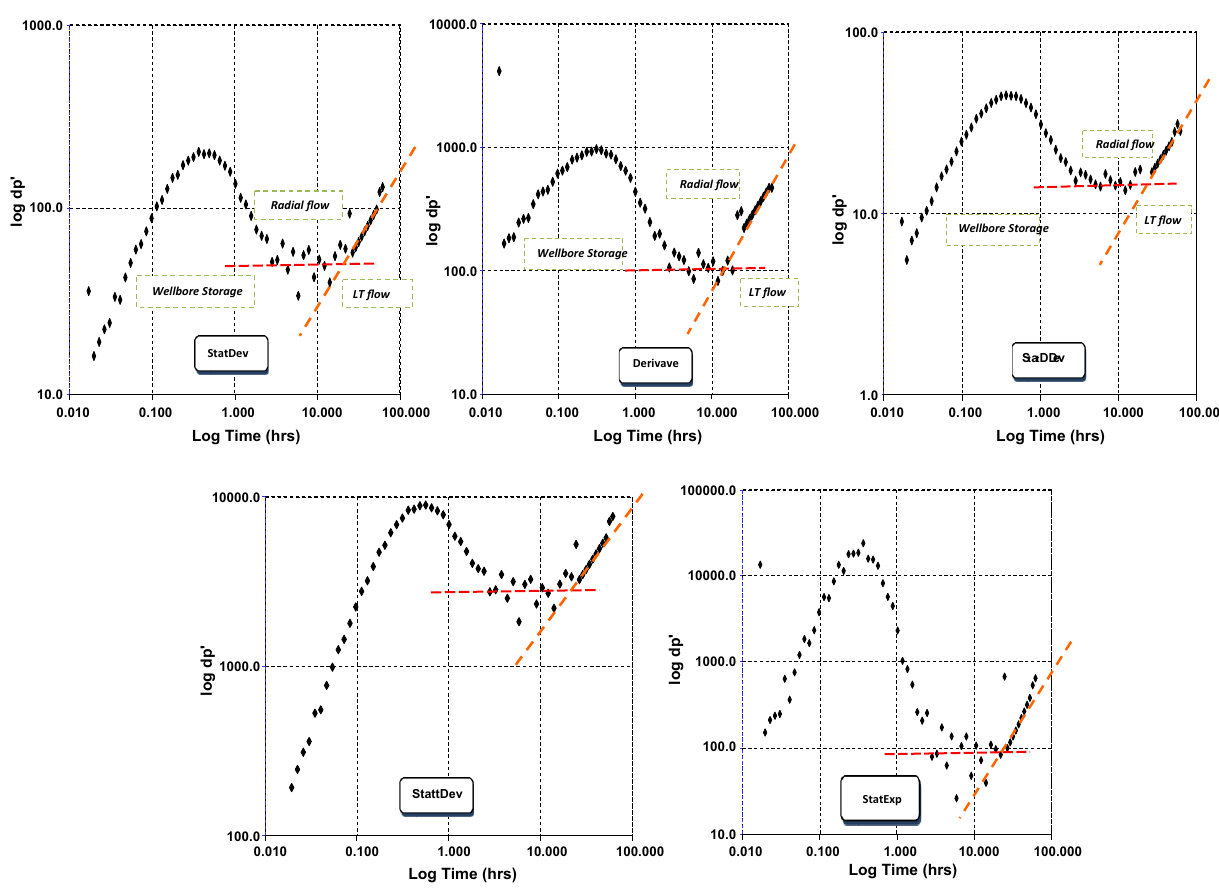
Fig. 4 Comparisons of StatDdev and StattDev diagnostics